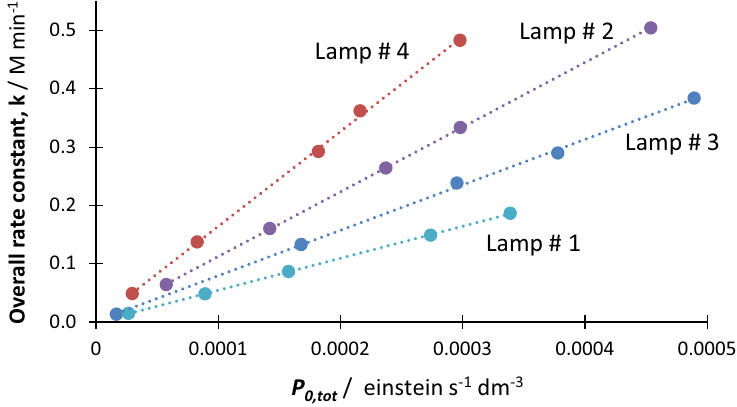
Figure 9. Linear relationships obtained for NIF (2.69 × 10 –5 M in ethanol) between the overall rate constants, k η , measured for various lamps intensities and the corresponding total radiant power, P (cid:31) (cid:31) (Lamp #1–Lamp #4, Fig. 1).